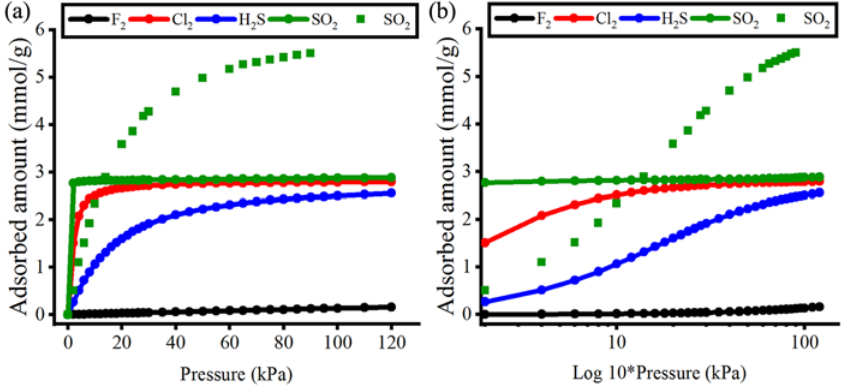
Figure 3. Simulated adsorption isotherms of gas molecules in CALF-20 MOF: ( a ) linear plot and ( b ) log10 plot. The square symbols represent the adsorption isotherms of SO 2 in ZIF-69 [72].